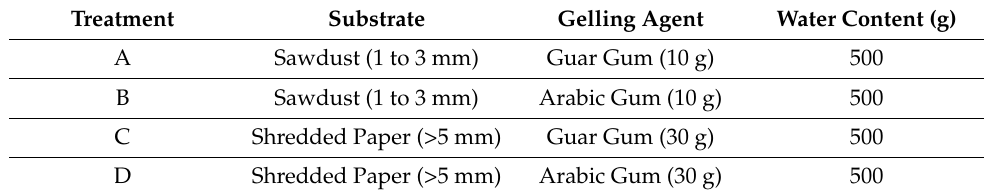
Table 1. Mixture Properties for the First set of Experiments.